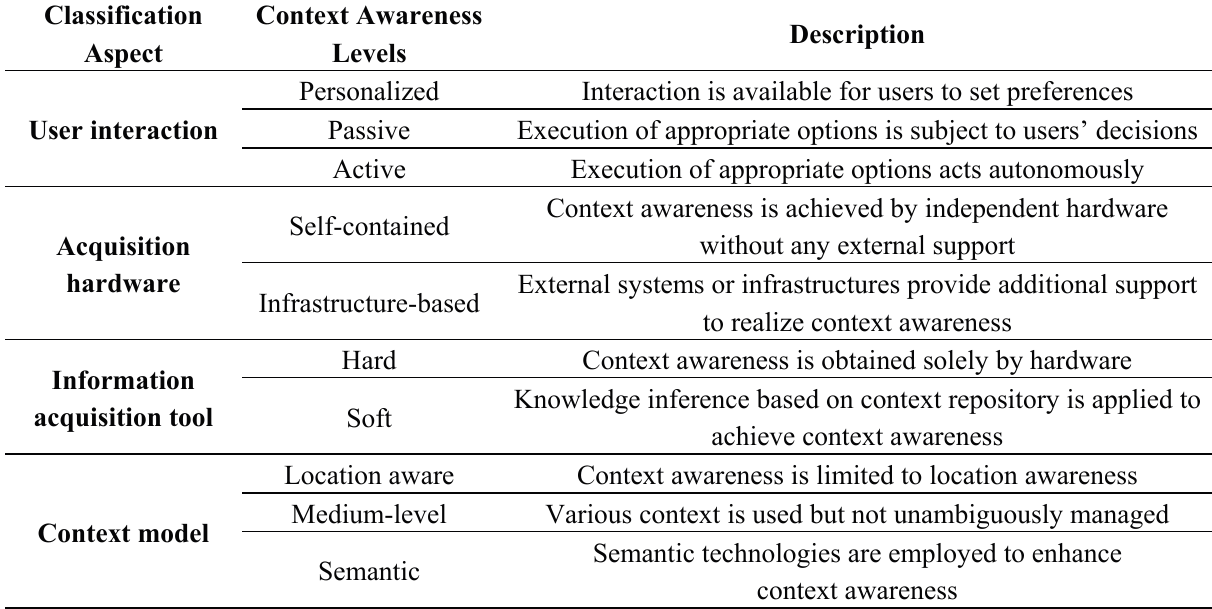
Table 2. Comparison of context awareness